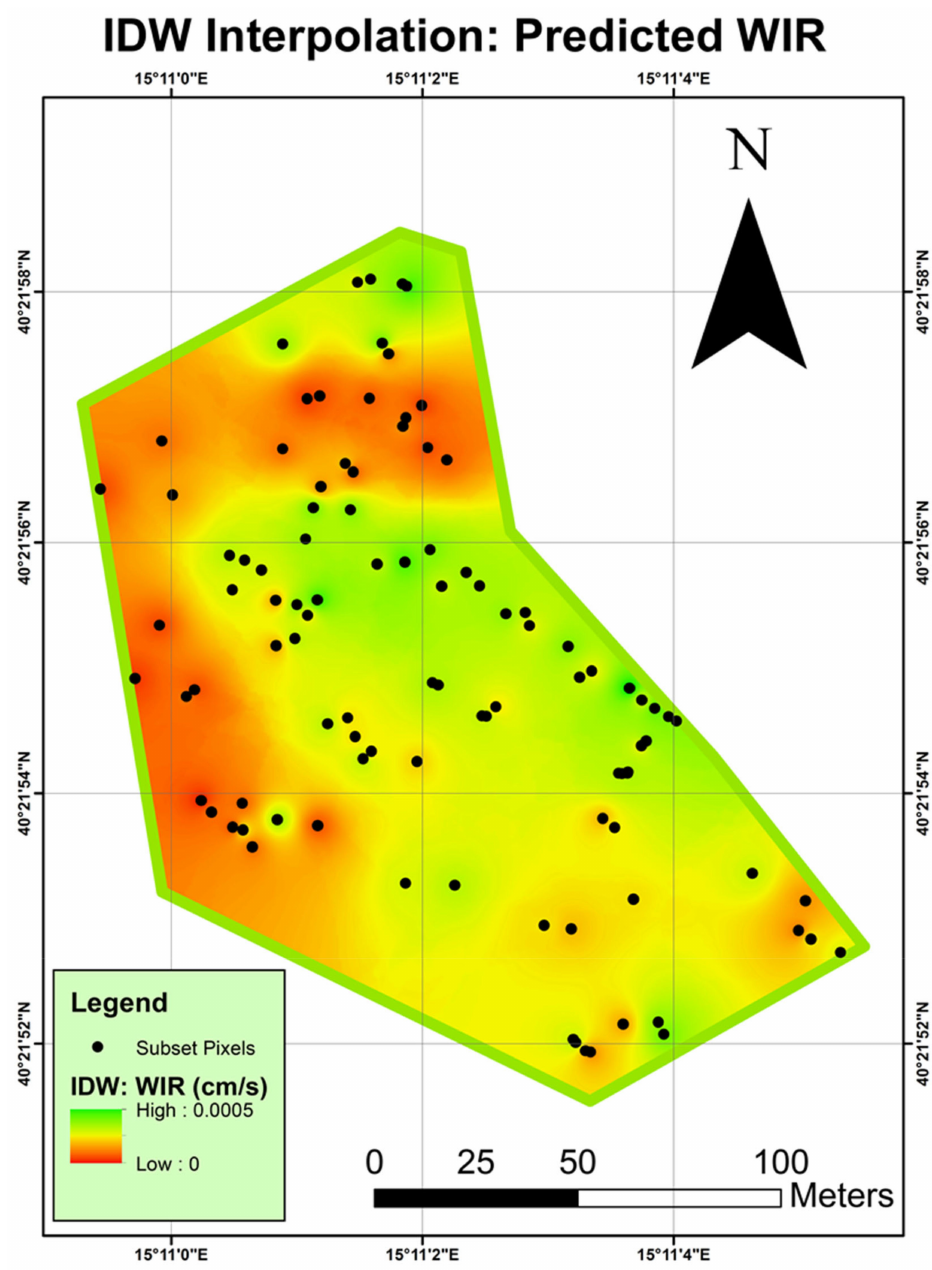
Figure 17. IDW interpolation of the predicted WIR after execution of the spectral-based model on the exposed soil pixels in the hyperspectral